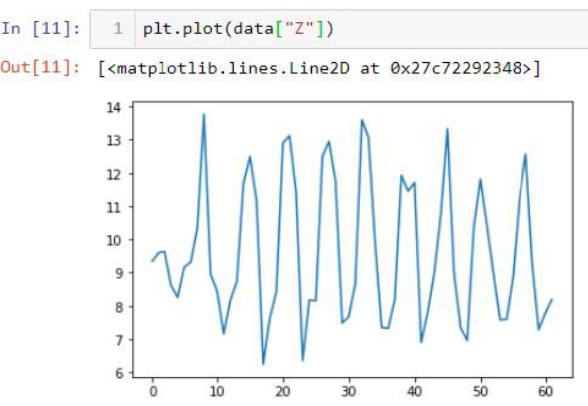
Figure 42. Visualization of the y -axis.